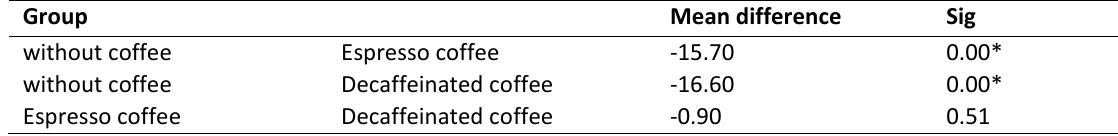
Table3. Bonferroni post hoc tests